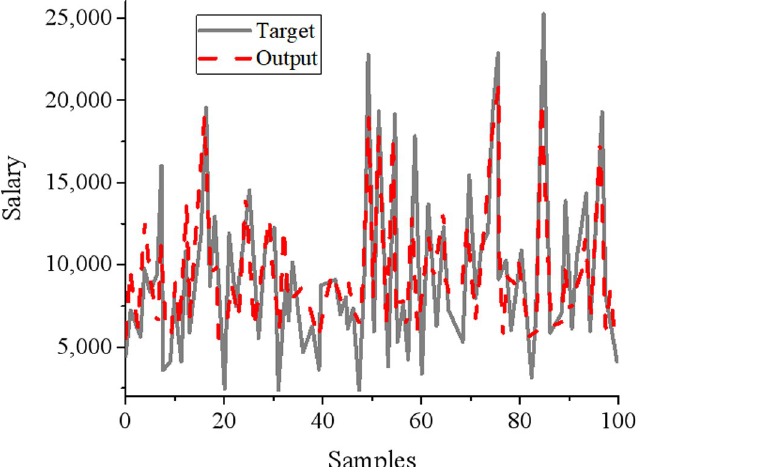
Fig 10. The fitting effect of Nadm-optimized salary forecast model.